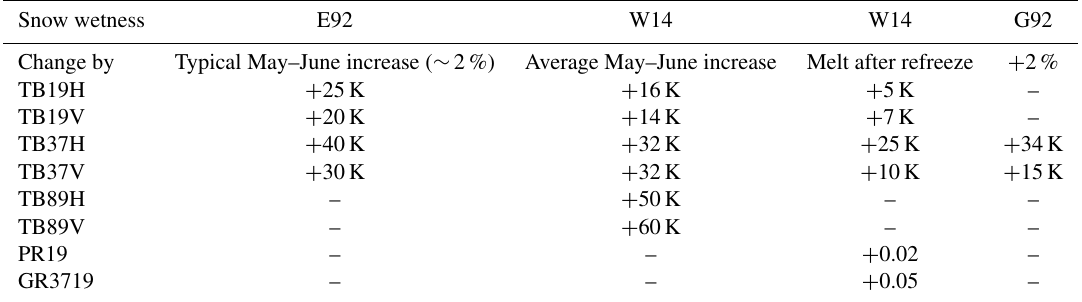
Table 1. Typical values of changes in brightness temperature due to changes in snow wetness. Abbreviations TB, PR, GR, V, and H denote brightness temperature, normalized brightness-temperature polarization difference (“polarization ratio”), normalized brightness-temperature frequency difference (“gradient ratio”), vertical, and horizontal (polarization), respectively. Abbreviations E92, W14, and G92 refer to Eppler et al. (1992), Willmes et al. (2014), and Garrity (1992), respectively. Snow wetness E92 W14 W14 G92 Change by Typical May–June increase ( ∼ 2%) Average May–June increase Melt after refreeze